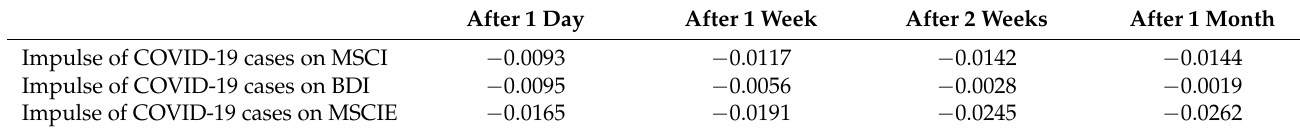
Table 4. The cumulative impulse of COVID-19 cases on MSCI, BDI, and MSCIE.